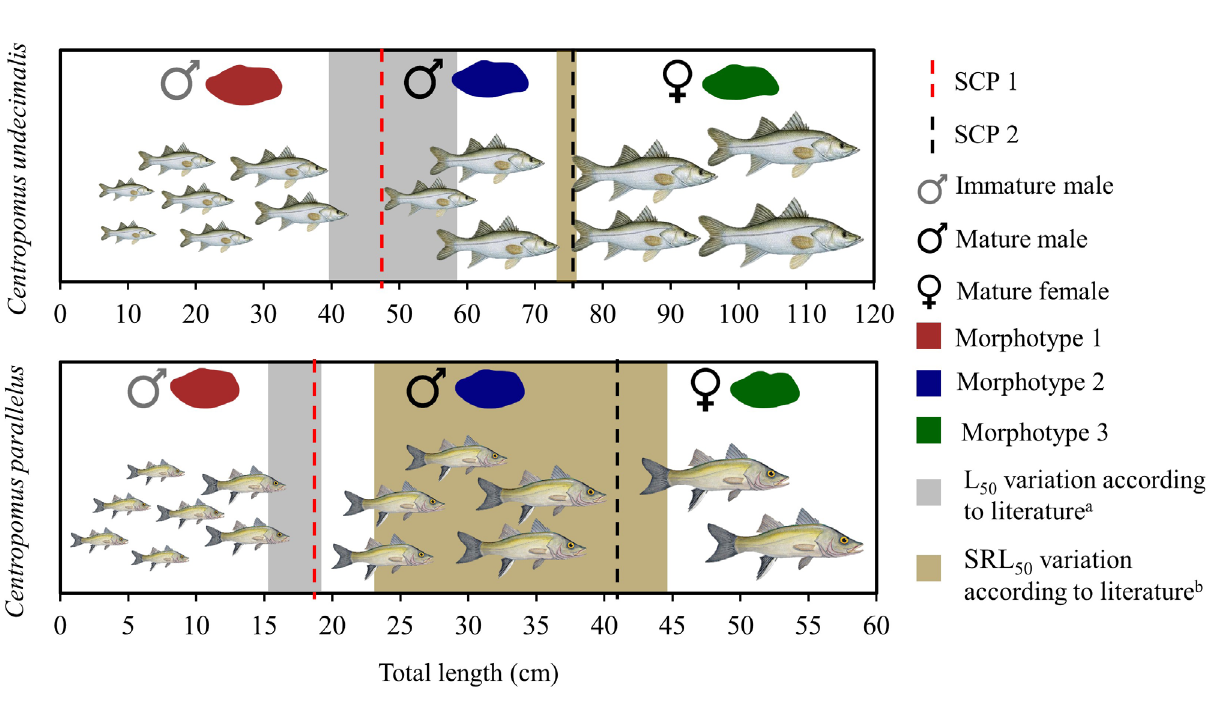
FIGURE 7 | Ontogenetic phases for Centropomus undecimalis and Centropomus parallelus , and indications of growth stanzas. L length; SRL = sexual reversion length; literature a for C. undecimalis = Gassman et al . (2017) and Cruz-Botto et al . (2018); literature a for C. 50 parallelus = Cunha Chaves, Nogueira (2018), Assis et al . (2019) and Costa e Silva et al. (2021); literature b for C. undecimalis = Gassman et al . (2017) and Young et al . (2020); literature b for C. parallelus = Cerqueira (2005), Gómez-Ortiz et al . (2011) and Assis et al .